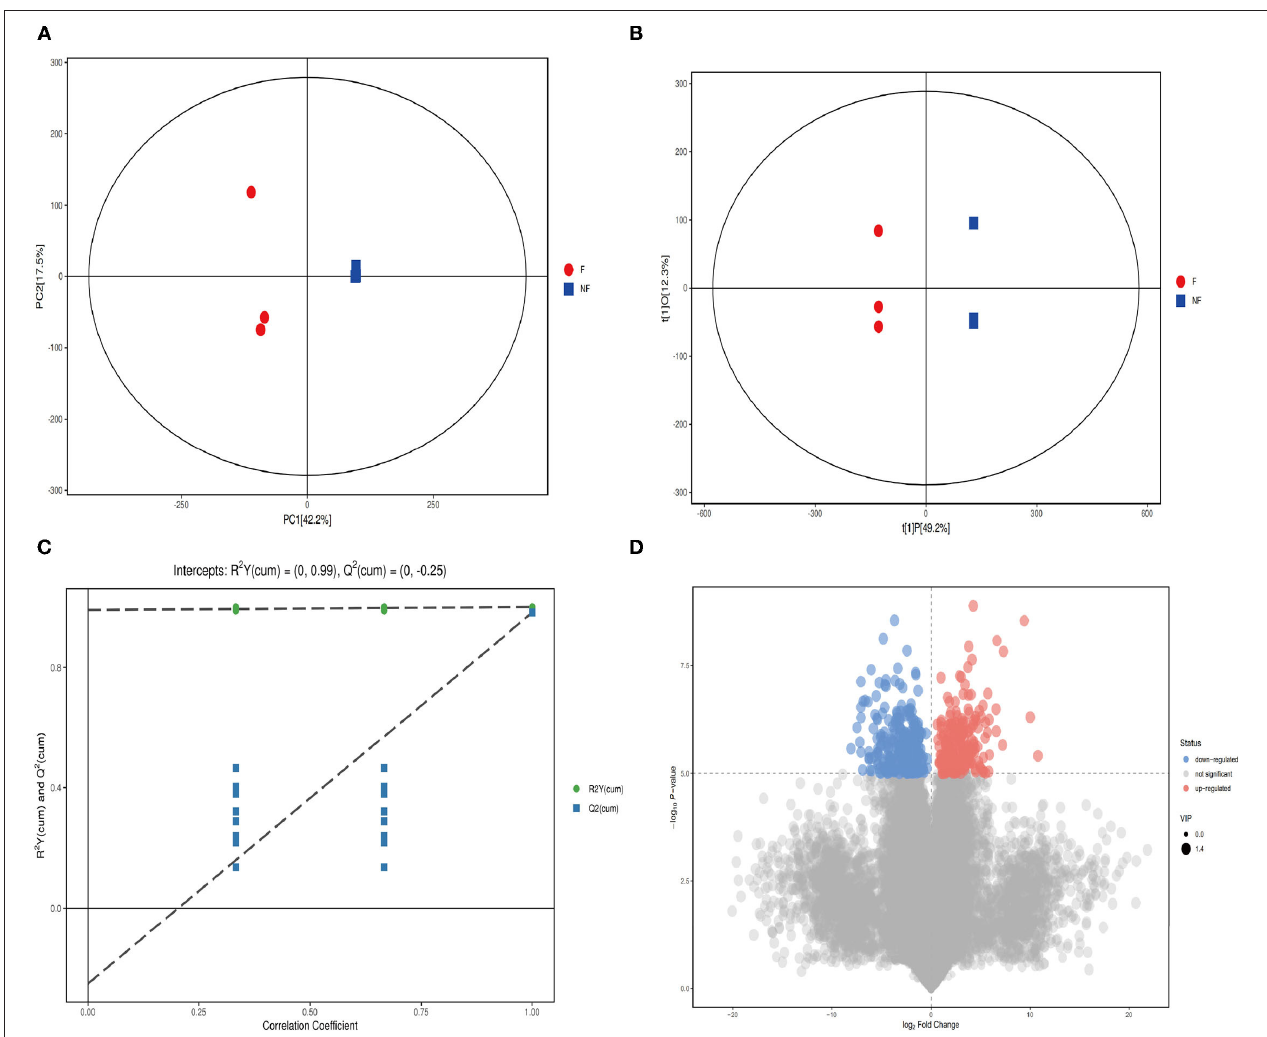
FIGURE 3 | Identification of discriminating biomarkers of fermented P. notoginseng leaves metabolomics analysis. (A) The OPLS-DA score plot in ion mode. (B) The PCA score plot in ion mode. (C) The H volcanic figure plot in ion mode. (D) The validation plot for the OPLS-DA model is built for negative, the slope of R2 is greater than 0, and the intercept of Q2 on the Y-axis is less than 0.05, indicating a valid model, the scattered shape and color of Figure. Three represent disparate studied